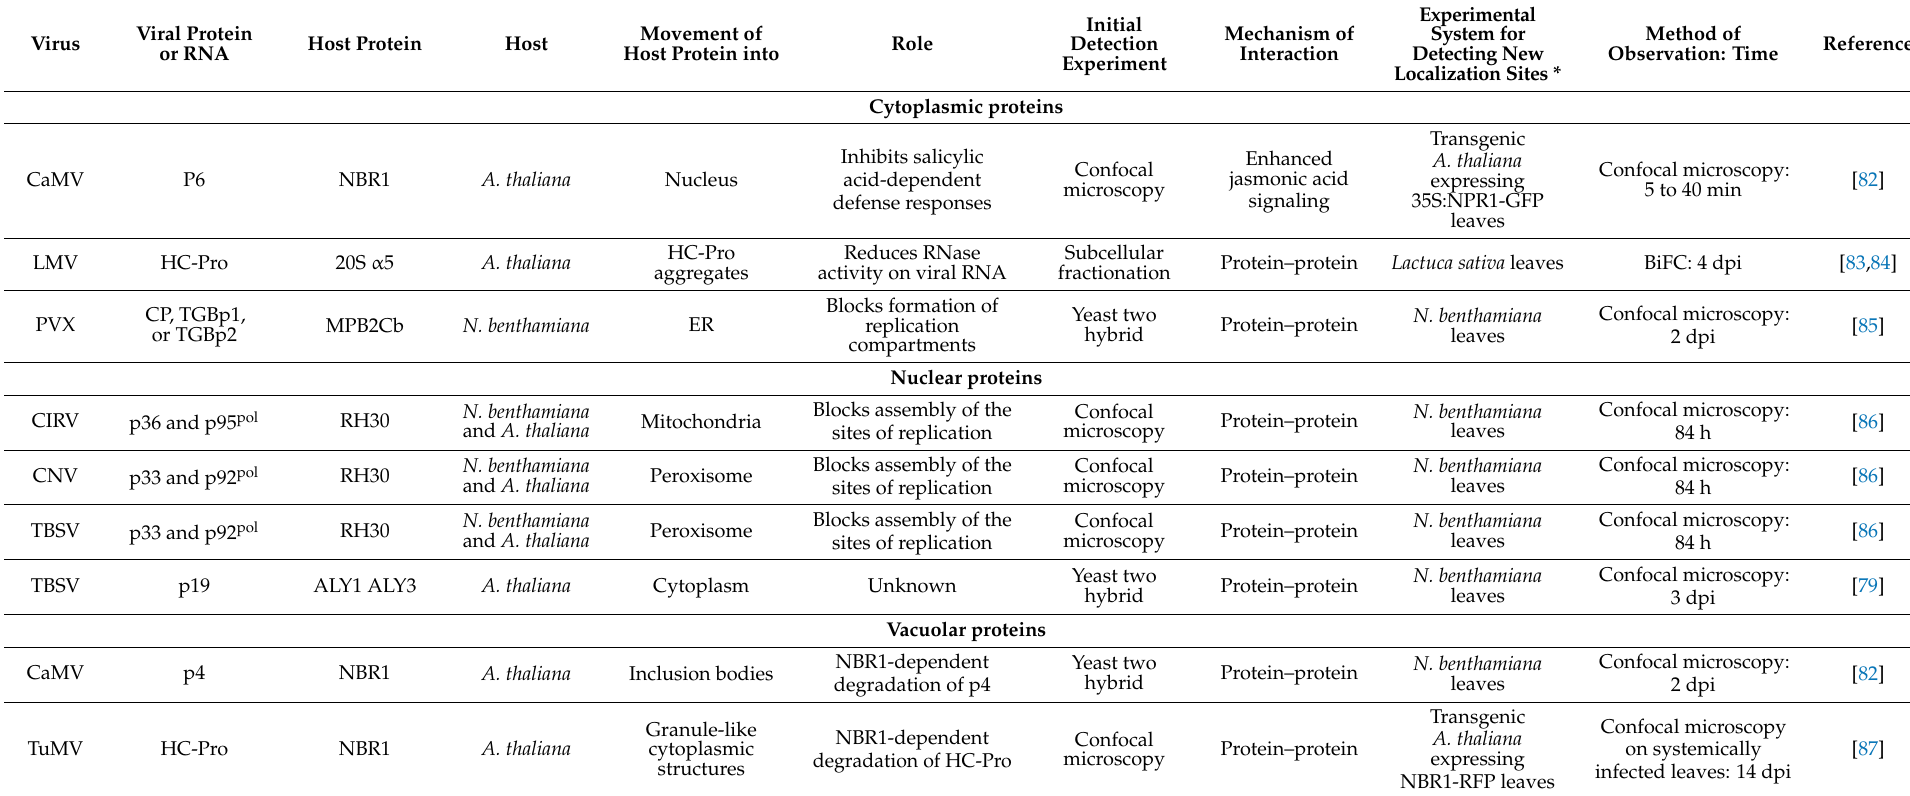
Table 3. Host proteins with antiviral activity and that change subcellular localization in the presence of a plant virus. Host proteins are organized in blocks based on their natural distribution in the absence of